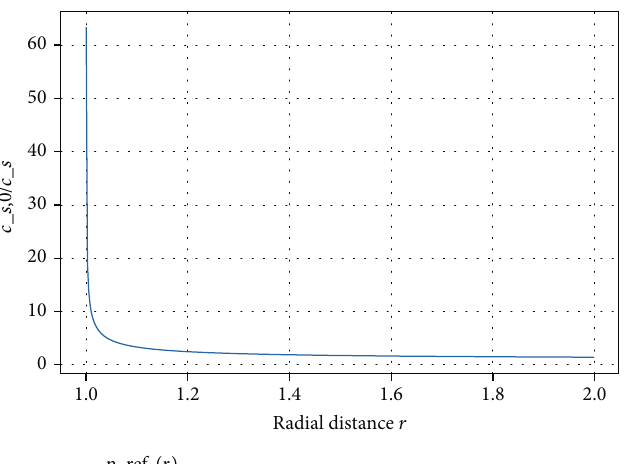
p ffiffiffiffiffiffiffiffiffiffiffiffiffiffiffiffiffiffiffiffiffiffiffiffiffiffiffiffiffiffi = c − 2GM/ r Þ 1/ ð h . ref ð r Þ 1 s ,0